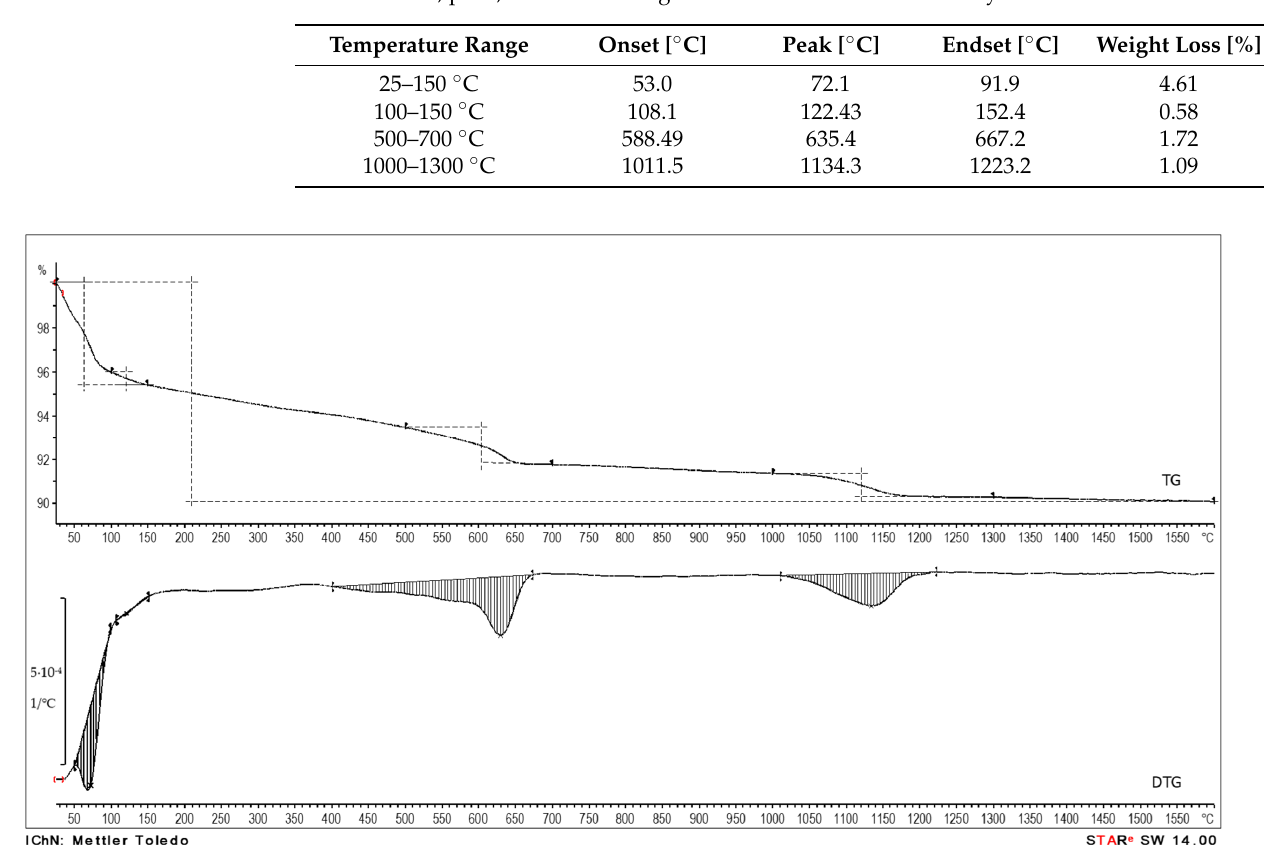
Table 4. Onset, peak, endset and weight loss of MSWIBA in DTG analysis.